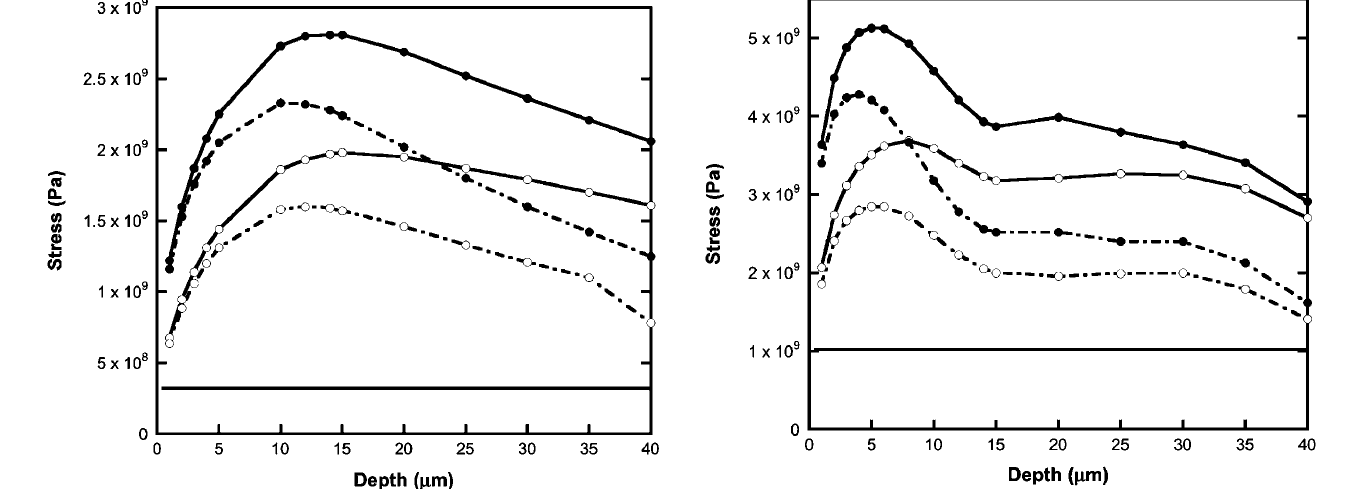
FIG. 7. Average and maximum stress at the bottom of a round- bottomed crack (with and without sidewall heating) versus crack depth, compared with plane surface stress (straight line at lower part of the plot). Pulse duration 2 : 1 (cid:1) s , heat flux q ¼ 2 : 7 (cid:3) 10 9 W = m 2 is applied. Both solid curves represent the case with sidewall heating along the crack with the closed symbol for the maximum stress at the crack bottom and the open symbol for the average stress over the semicircled crack bottom. The dashed curves denote no sidewall heating cases, with the closed symbol for the maximum stress at the crack bottom, and the open symbol for the average over the crack bottom.